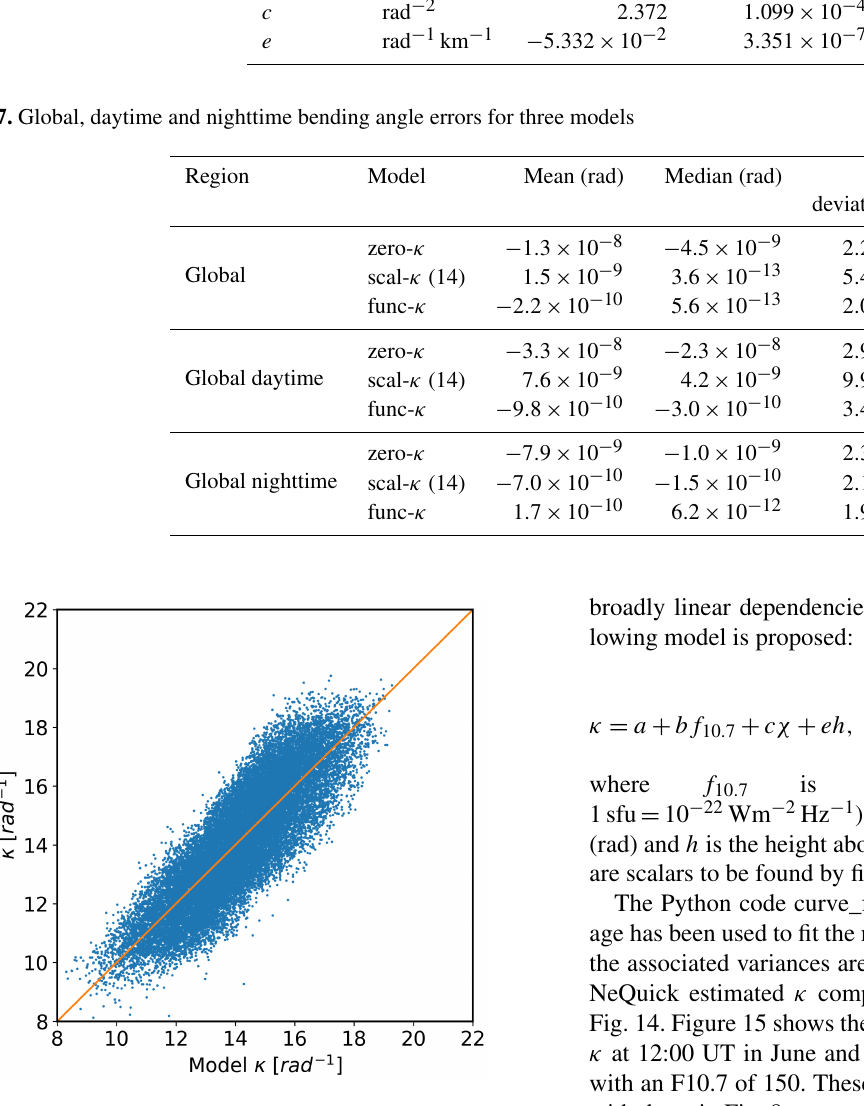
Figure 14. Scatter plot of κ estimated from NeQuick compared to modelled κ